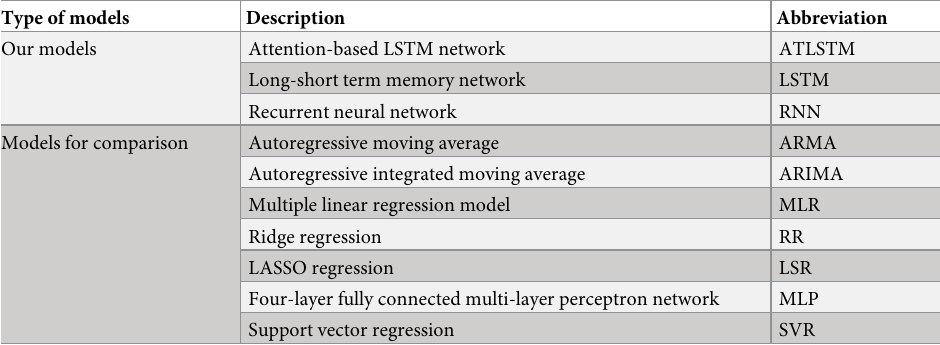
Table 2. The training models and their